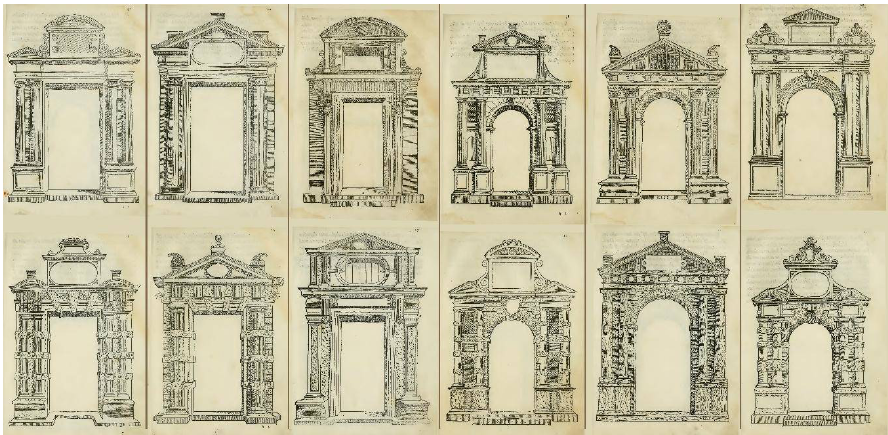
Figure 6. Oppositional pairs of doors ‘rustiche’ and ‘dilicate’ with a comparable geometric-formal structure, from the Libro estraordinario .